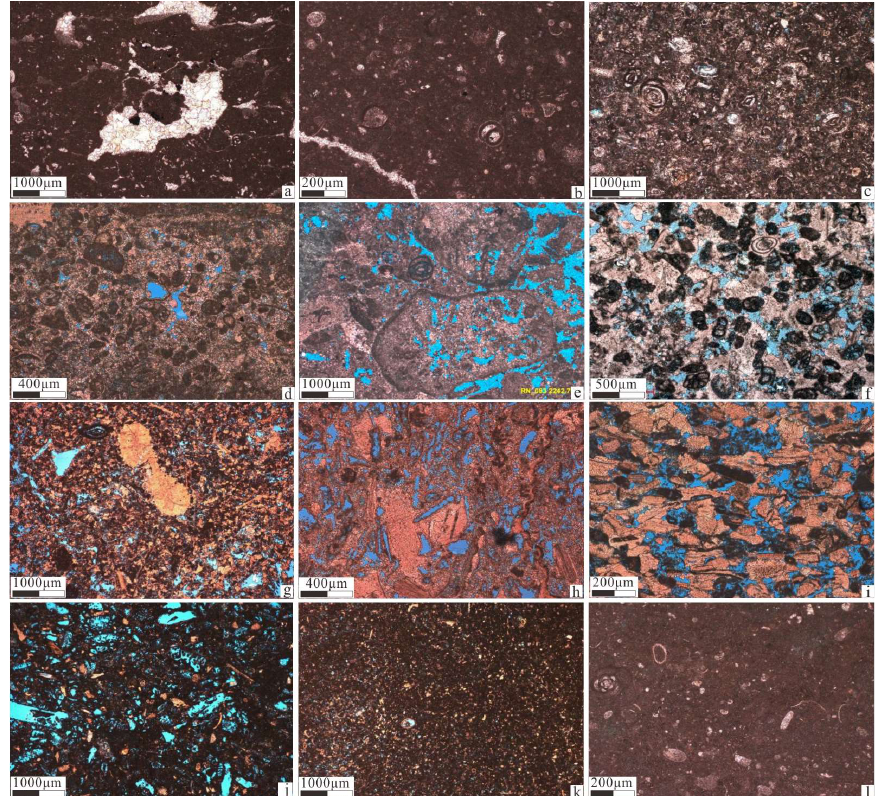
Figure 6. Microfacies type and characteristics of Mishrif Formation in X Oilfield. ( a ) MFT1, well W002, 2770.24 m; wackstone, geopetal structure, and birdseye structure; ( b ) MFT2, well W002, 2298.02 m, wackstone with small benthonic foraminifera ; ( c ) MFT3, well W002, 2280.06 m, packstone with large amount of benthonic foraminifera ; ( d ) MFT4, well W017, 2382.58 m, grainstone with small benthonic foraminifera ; ( e ) MFT5, well W083, 2242.76 m, grainstone with mega bryozoan and small benthonic foraminifera ; ( f ) MFT6, well W0186, 2350.24 m, grainstone with benthonic foraminifera, bival- via and echinoderm, the particles sort well; ( g ) MFT7, well W017, 2500.31 m, grainstone with large amounts of small unrecognized particles, some mega rudist and benthonic foraminifera can be seen; ( h ) MFT8, well W017, 2501.13 m, grainstone with bivalvia, dissolution is intense; ( i ) MFT9, well W002, 2321.8 m, grainstone with benthonic foraminifera and rudist ; ( j ) MFT10, well W002, 2353.04 m, packstone with green algae ; ( k ) MFT11, well W002, 2371.05 m, packstone with large amounts of fine particles unrecognized; ( l ) MFT12, well W002, 2285.26 m, wackstone with few ostracoda. Three types of HFZs in the Mishrif reservoir X field were classified in the carbonate ramp, which were of the platform margin shoal type, the tidal channel type, and the point shoal type. HFZs are the result of the coupling of a high-energy environment and con- structive diagenesis. The HFZ core in the platform margin shoal is dark brown, and pores produced by dissolution are visible to the naked eye. The particles are mainly rudist de- tritus, which are well sorted, and develop intergranular pores and visceral foramen (Fig- ure 7a). The HFZ core in the tidal channel is dark yellow, showing cross-bedding and bottom scour structures. The particles are dominated by bivalves , echinoderms , and benthic foraminifera , with high structural maturity, and intergranular pores are mainly developed (Figure 7b). The HFZ core in the point shoal is yellow-brown, and biological debris is vis- ible to the naked eye. The bioclast are poor in terms of sorting and have developed mi- cropores and vug pores (Figure 7c).